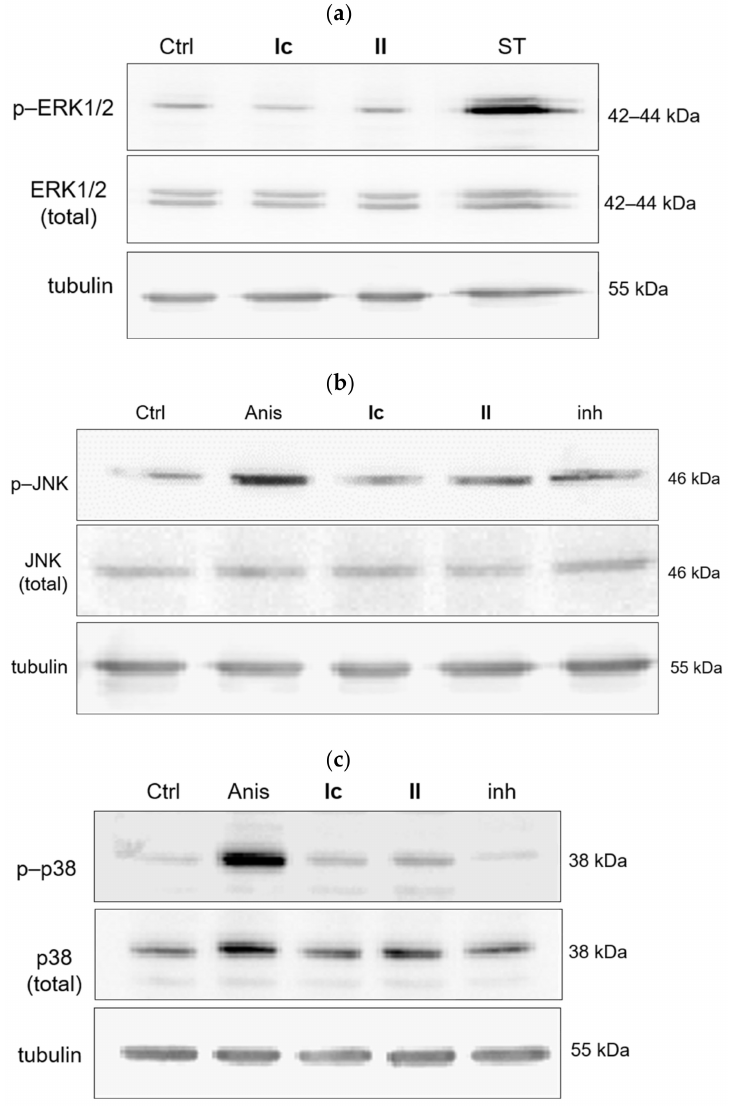
Figure 4. Effect of dicarboximides Ic and II on activation of ERK1/2 ( a ), JNK ( b ), and p38 ( c ) kinases in K562 leukemia cells. Ctrl—control cells treated with 1% DMSO; Anisomycin 20 µ M (positive control, activator of JNK and p38 kinases); Ic (6 µ M); II (3 µ M); ST—Staurosporine 1 µ M (positive control, activator of ERK1/2); inh—JNK inhibitor 20 µ M or p38 inhibitor 10 µ